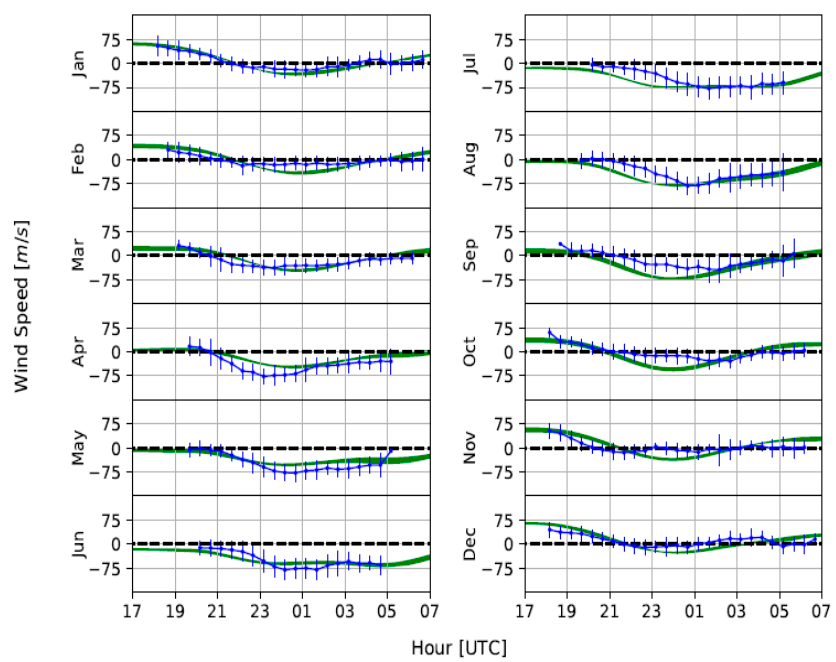
Figure 2. Meridional winds in Morocco for January 2014 to February 2016. The blue plots represent the FPI measurements, while the green plots represent corresponding HWM-14 predictions. The vertical error bars indicate the standard deviations of the observations. Adapted with permission from Ref. [23]. 2017, Kaab et al.